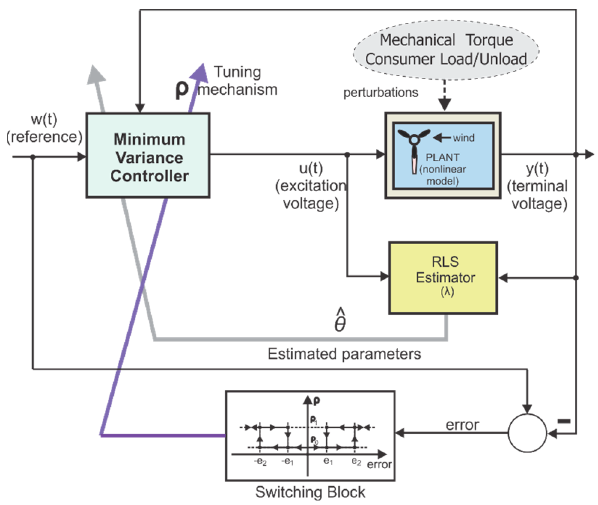
Figure 2. General structure of the proposed self-tuning minimum variance control system.